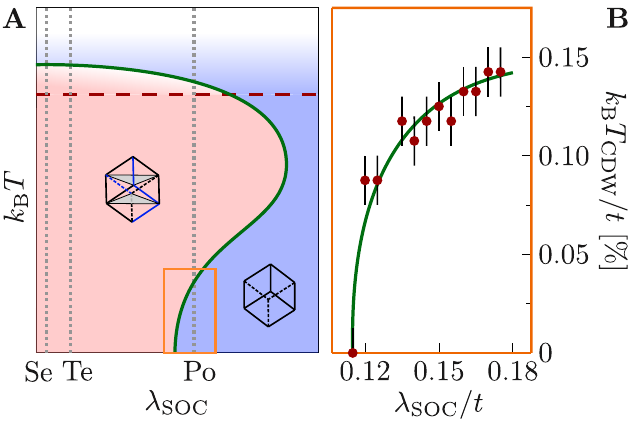
Figure 2: Phase diagram for elemental chalcogens as a function of temperature and strength of spin-orbit coupling. A . Schematic phase diagram. At low temperatures, increasing the strength of spin orbit coupling leads to a suppression of the trigonal instability, and hence a stabilisation of the simple cubic lattice. Polonium is expected to fall just to the right of the transition point, and thus to have a simple cubic ground state, while Selenium and Tellurium have low spin-orbit interaction, and thus a trig- onal ground state structure. At fixed spin-orbit coupling, starting from the trigonal phase, the melting point (schematically indicated by the red dashed line) is encoun- tered before charge and orbital order is destroyed and the local structure becomes cubic. Starting instead from the simple cubic phase, thermal expansion of the lattice lowers the bare phonon energy and thus shifts the balance of competing interactions in favour of the trigonal phase. B . The transition temperatures between cubic (lower right) and trigonal (upper left) phases, found by self-consistently solving the mean field equations. The error bars indicate the uncertainty in assigning the transition point within the precision of our numerical routine, and the solid line is a guide to the